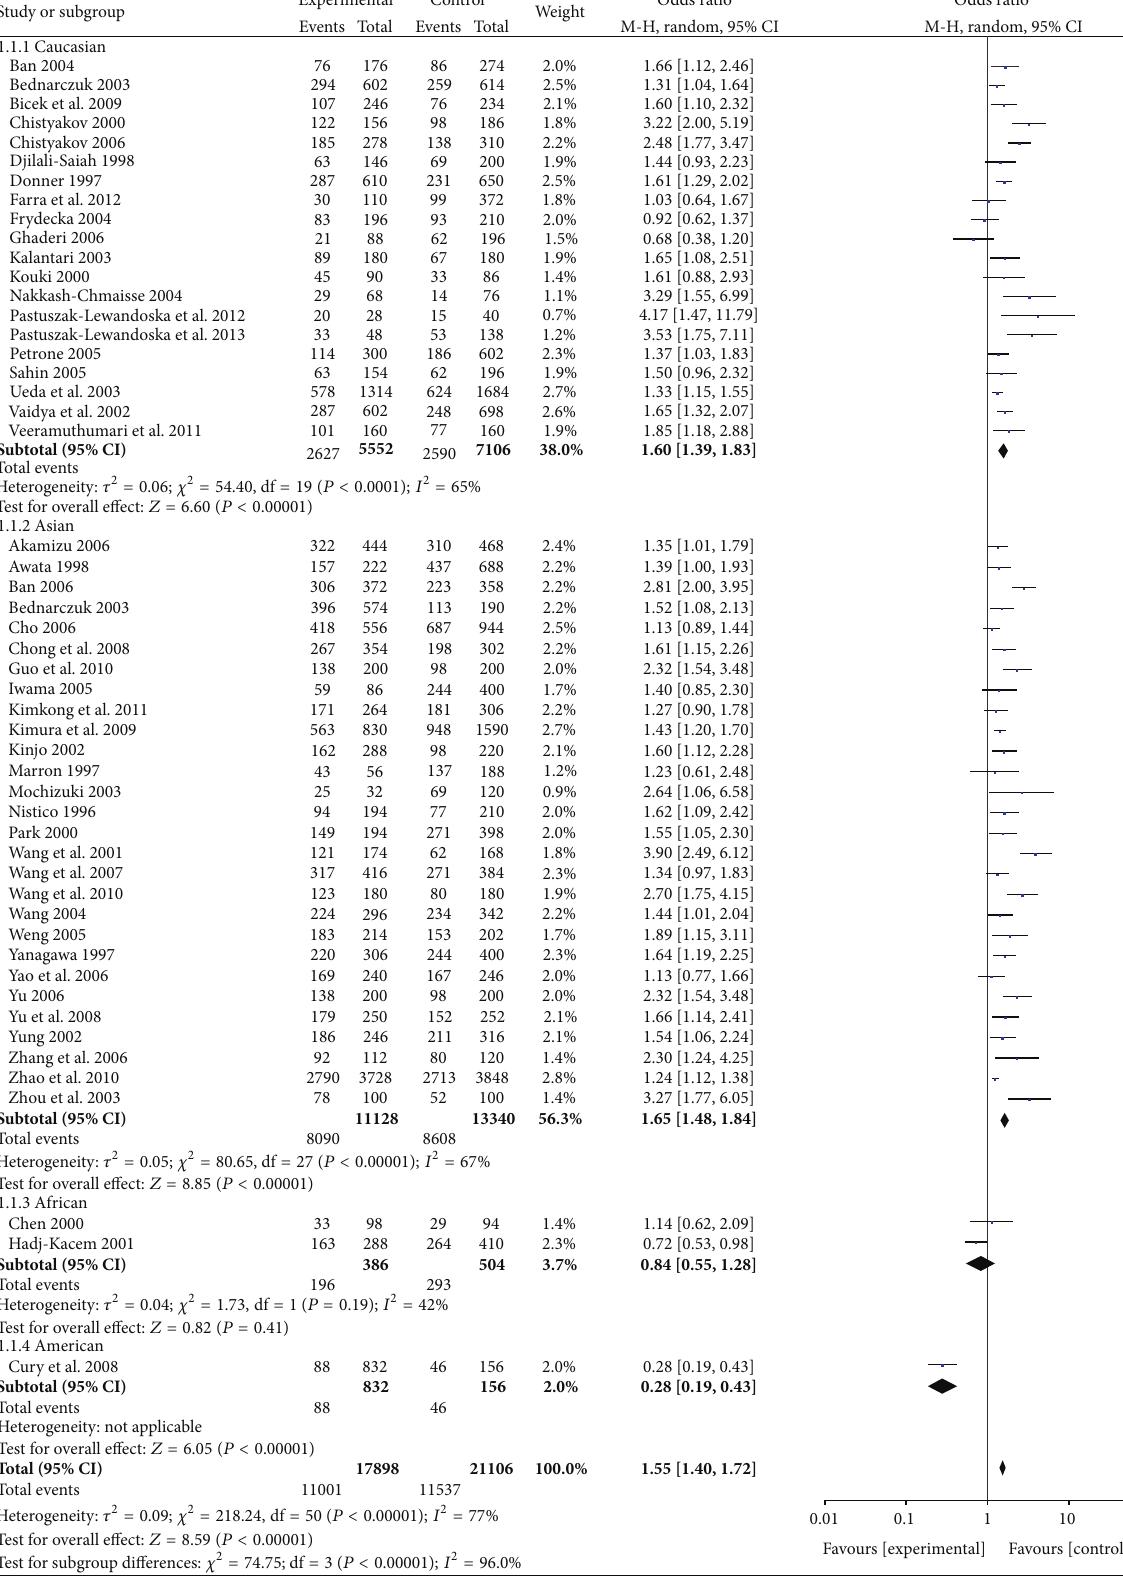
Figure 1: Forest plot of the association between an allele model of A49G polymorphism and